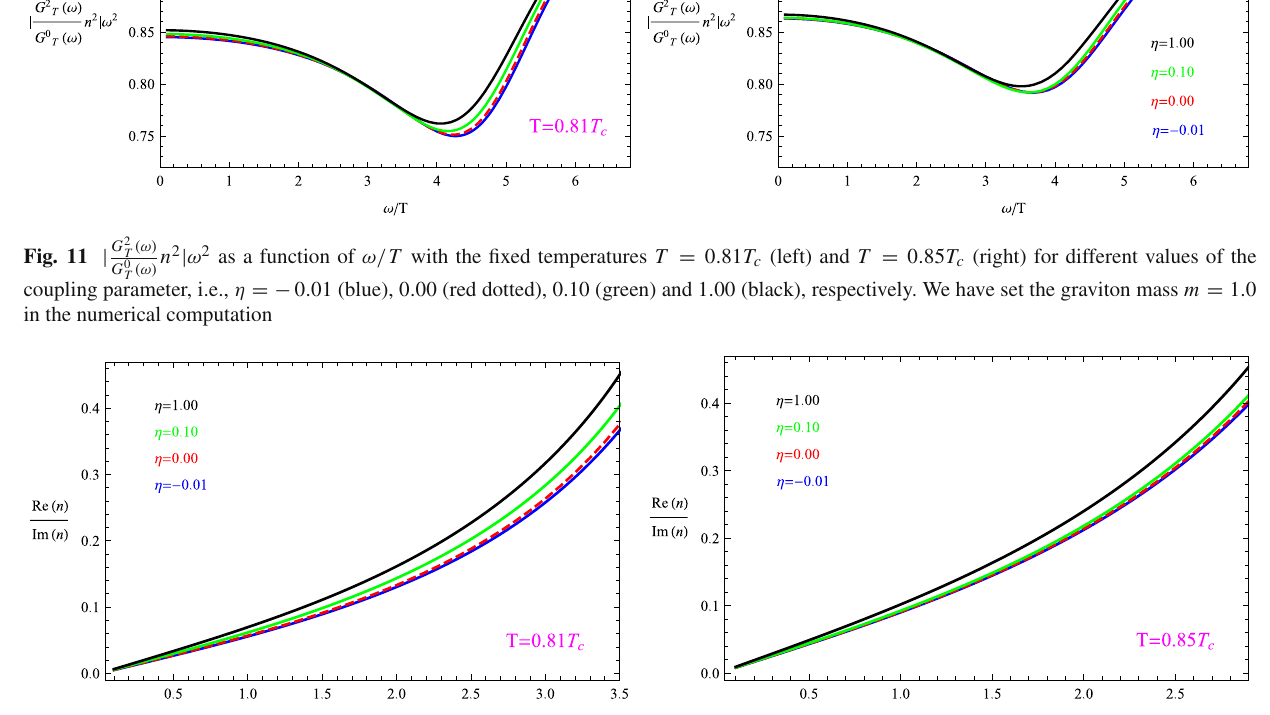
0.10 (green) and 1 . 00 (black), respectively. We have set the graviton mass m = 1 . 0 in the numerical